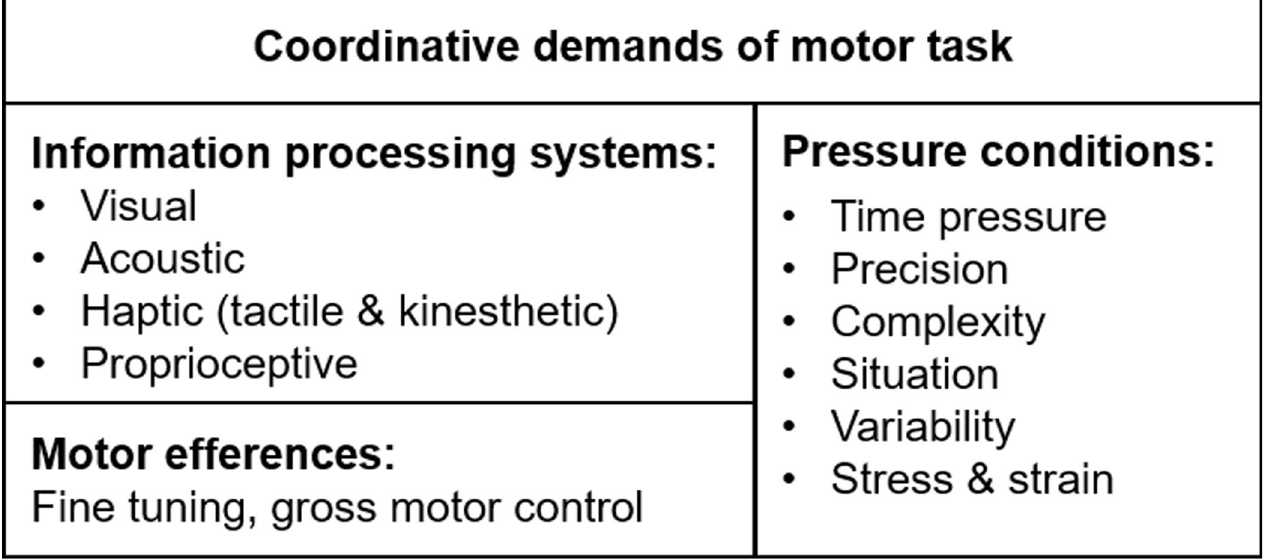
Fig 3. Coordination model of [17].